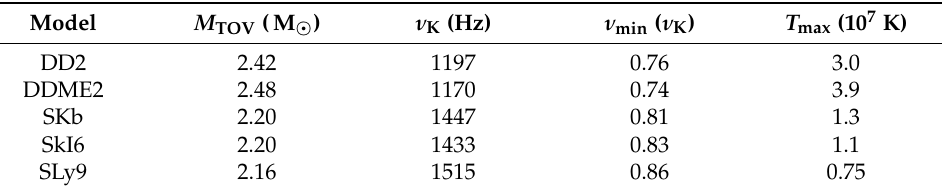
Table 1. The maximum mass of non-rotating neutron stars M TOV , the Kepler frequency ν K , and the minimum frequency ν min to support a neutron star of mass 2.50 M (cid:12) for the 5 EOSs used. T max is the maximum temperature for the m 2 to remain r-mode stable. Taken from [43].